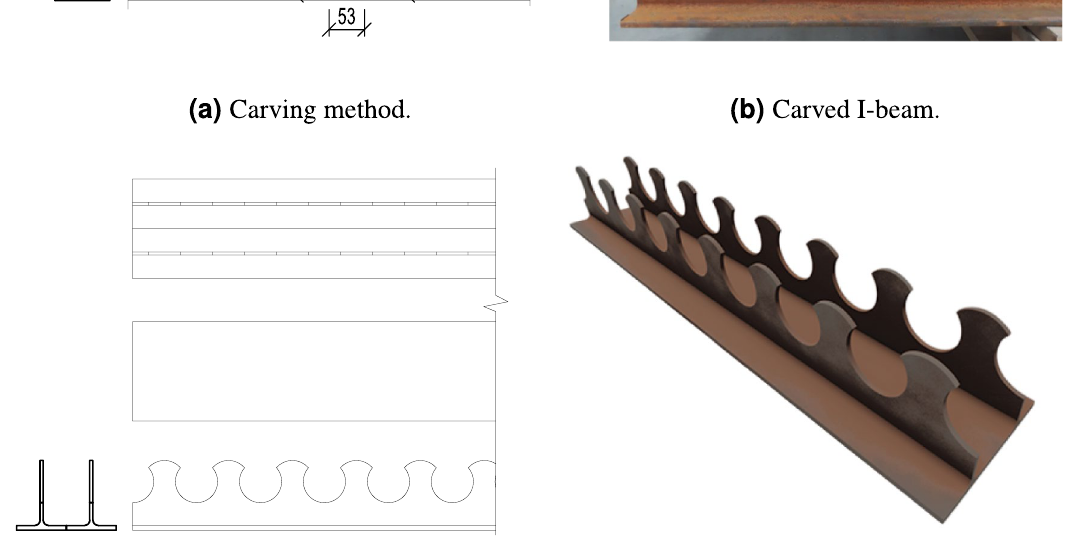
Figure 2. Design of the twin dowel.